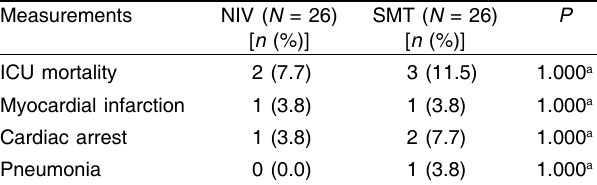
Table 6 Comparison between the study groups as regard mortality and